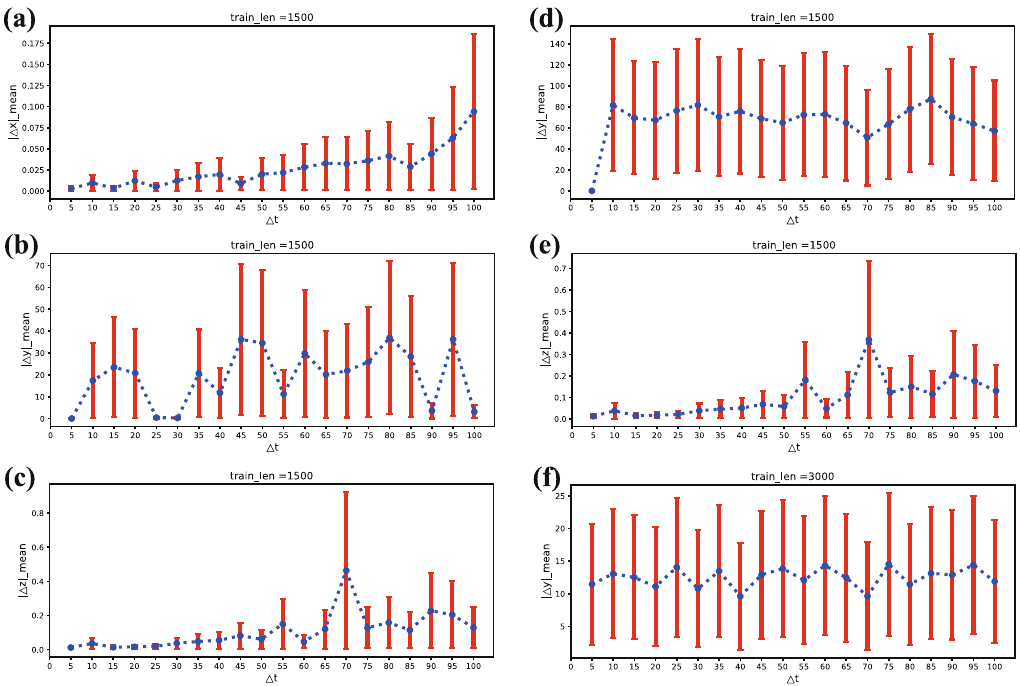
Figure 6. The reconstruction error of the Lorenz system versus the interval (cid:31) t (5–100) in the six modes. ( a – e ) The tendency of the reconstruction error and the interval (cid:31) t in the five modes (i.e., yz − x mode, xz − y mode, xy − z mode, x − yz mode, and y − xz mode) when T train = 1500. All the five modes can reconstruct well